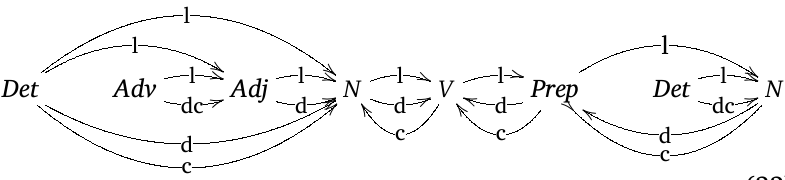
Constructions as complete